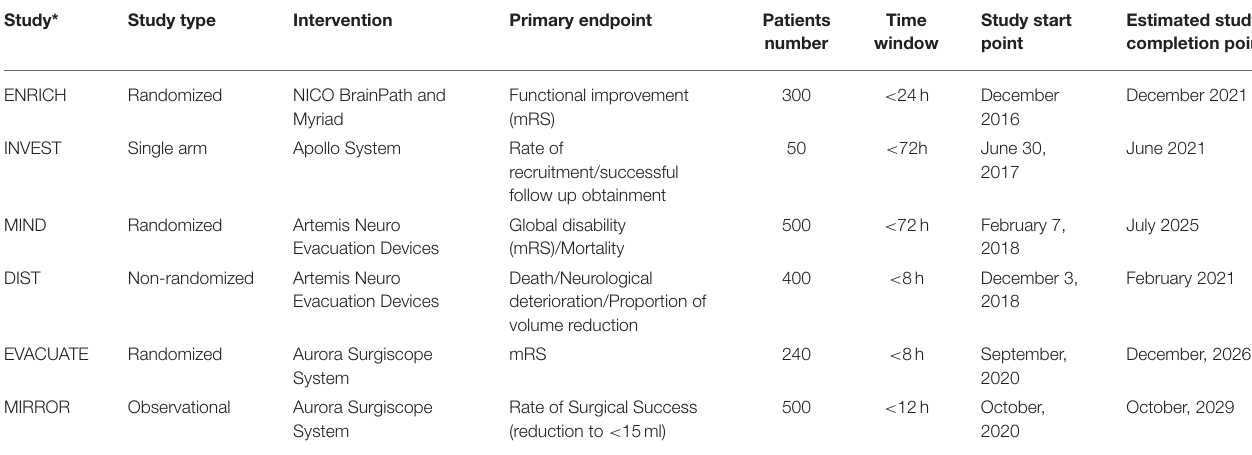
TABLE 2 | Ongoing studies of minimally invasive surgery for intracerebral hemorrhage.